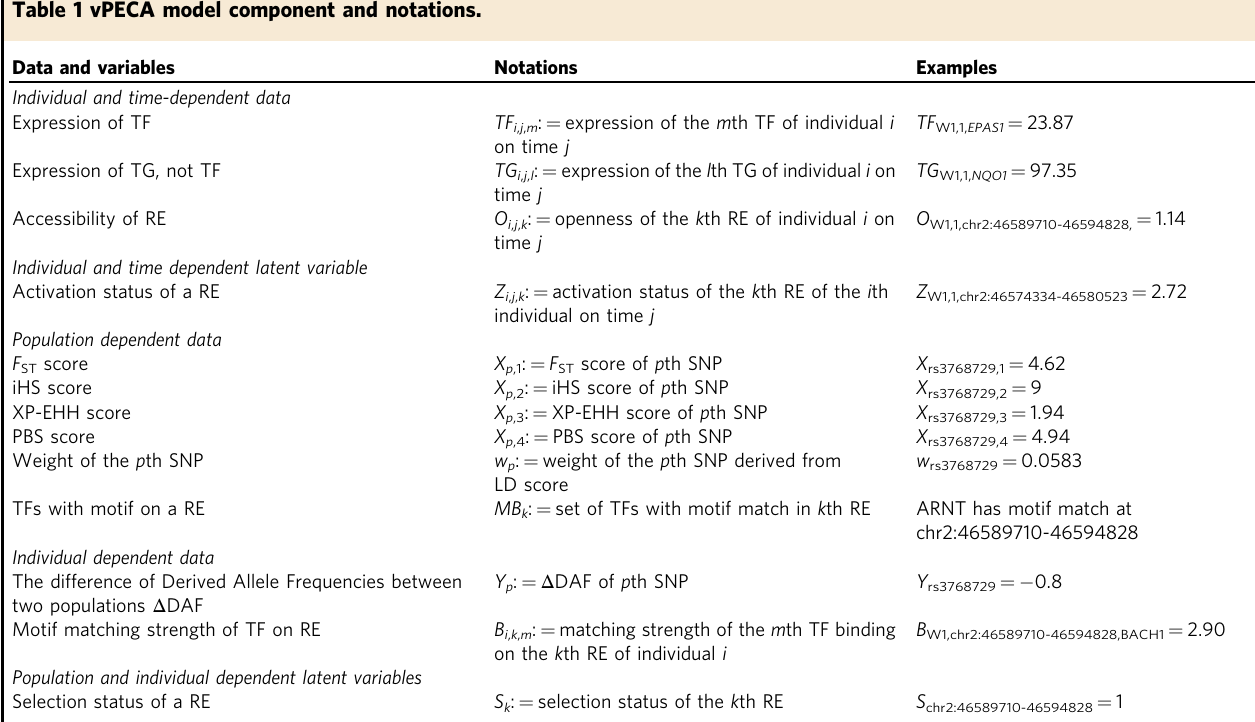
Table 1 vPECA model component and